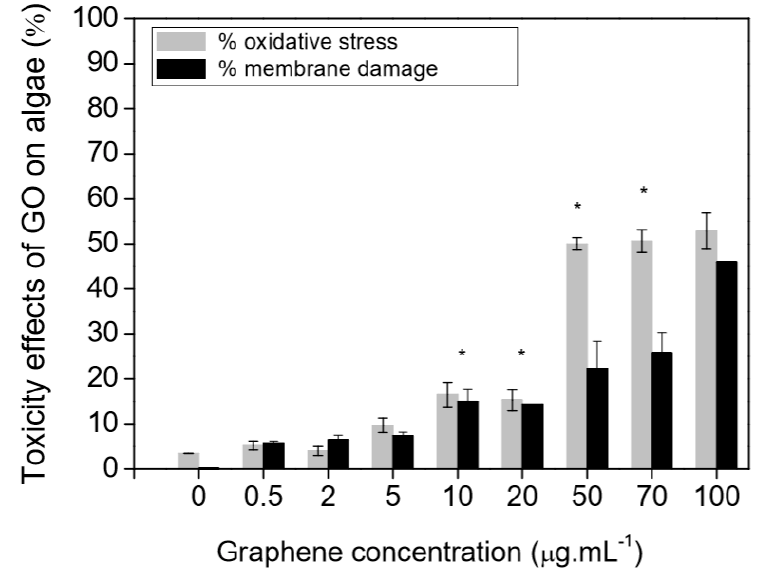
Figure 11. Toxicity effects (oxidative stress and membrane damage) of GO on R. subcapitata green alga; evaluated by flow cytometer. Values are mean +SD (N = 3). * statistically significant difference from control (p < 0.05). Reproduced from reference [178], with permission from Elsevier, 2015.